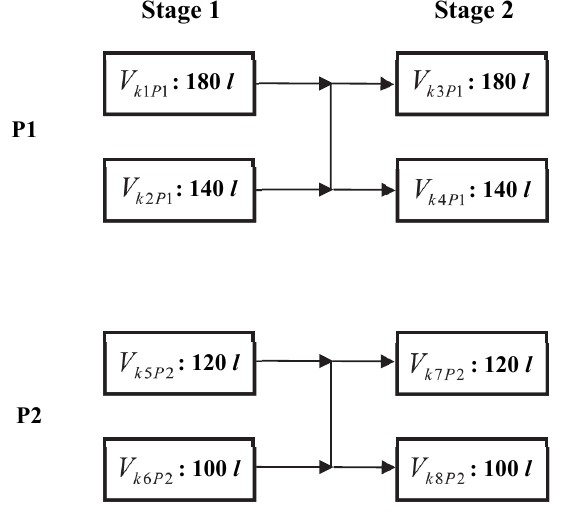
Fig. 1. Plants structure for Example